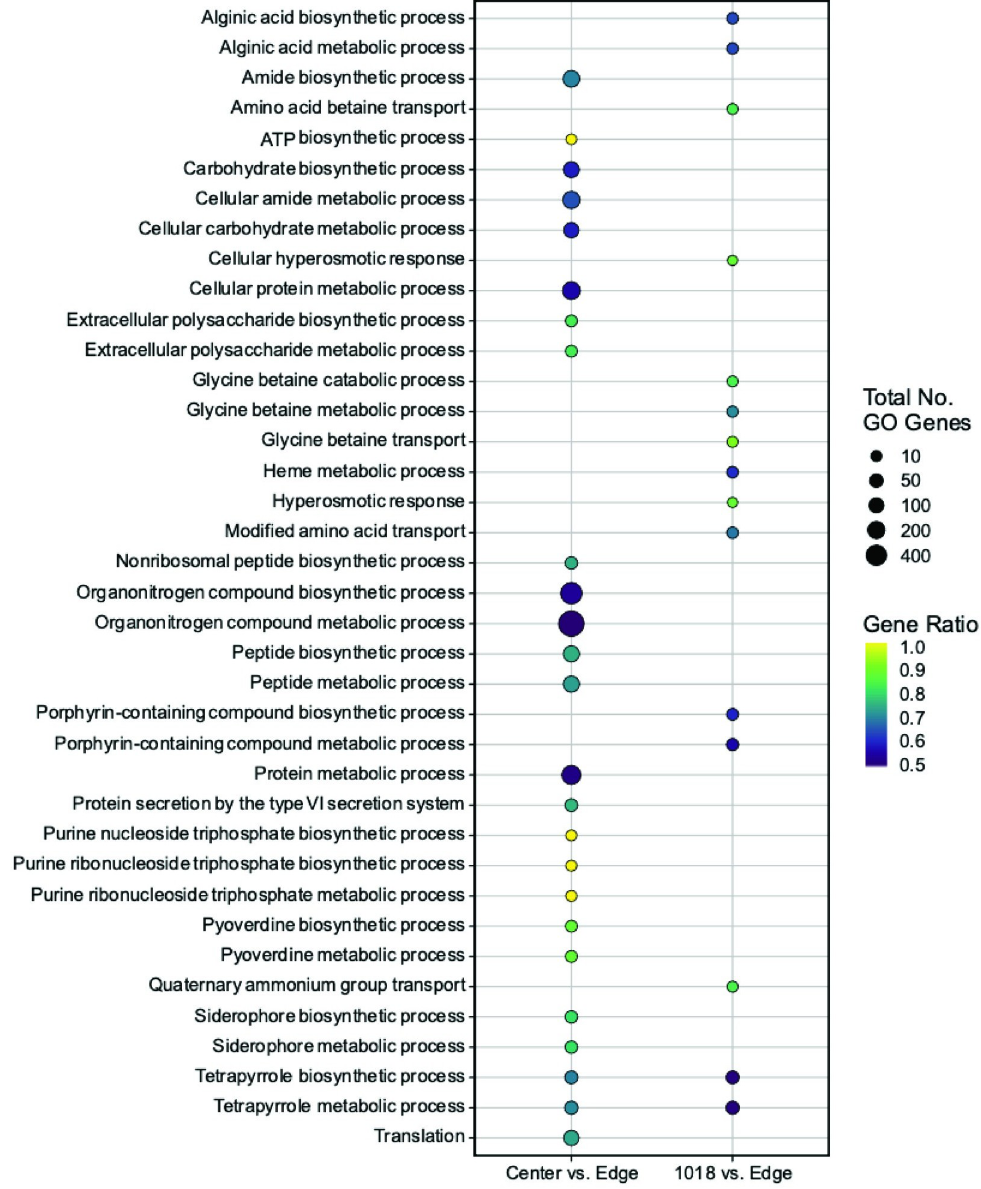
Fig 4. Functional classification of Differentially Expressed (DE) genes using Gene Ontology (GO) term enrichment. GO term enrichment was performed using GofuncR on the list of DE genes in cells treated with 1018 and cells at the centre of swarming colonies relative to cells at the edge of swarming colonies. GO terms were considered significant with a P � 0.05 and a multi-test corrected family-wise error rate (FWER) � 0.1. Cells treated with 1018, but not cells at the centre of swarming colonies, cf. swarming edge cells, exhibited functional enrichment in transport of small molecules, heme metabolism and amino acid